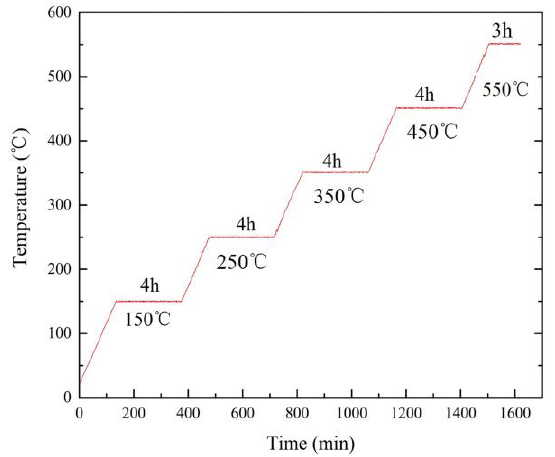
Figure 2. The scheme of multi-stage oxidation process. The scheme shows the details of multi-stage oxidation process.